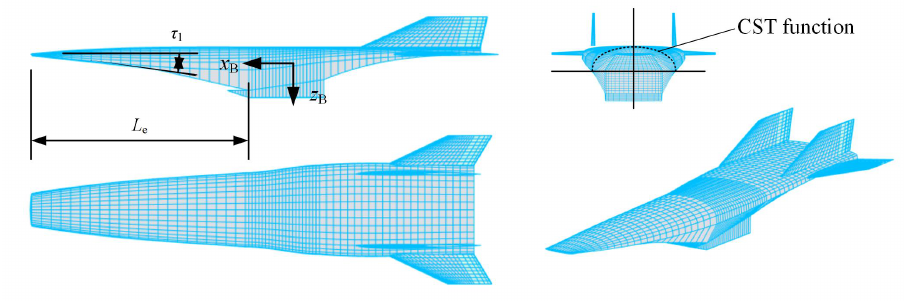
Figure 1. Geometrical configuration of aerospace